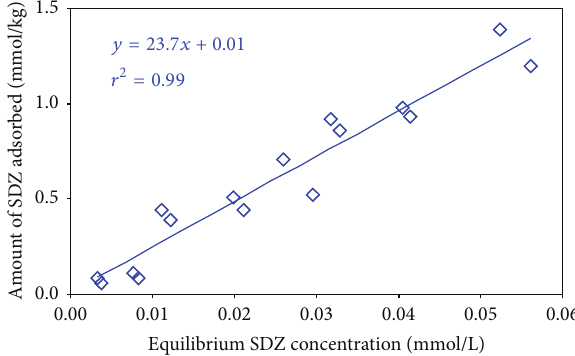
Figure 3: Adsorption of SDZ on zeolite. The solid line is the linear fit to the observed data.